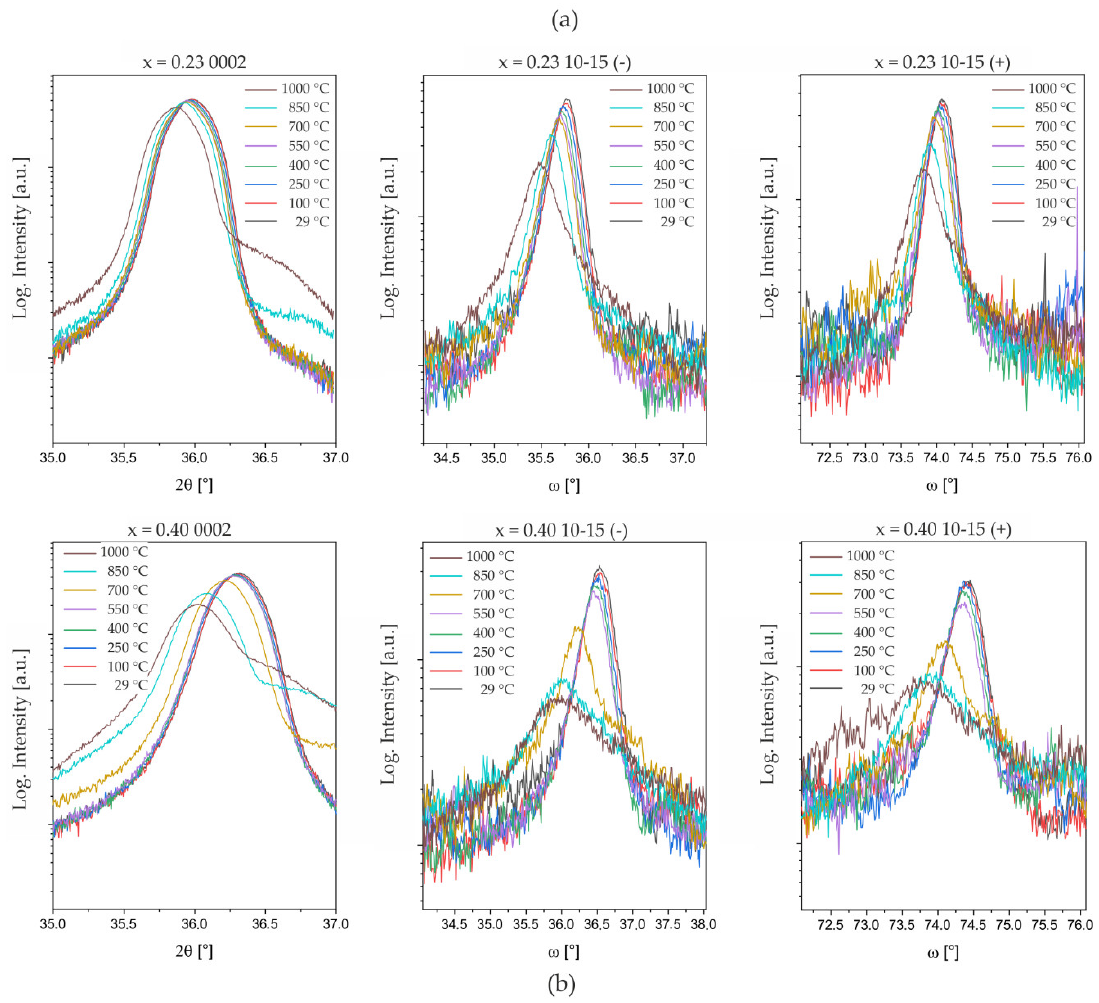
Figure 5. Temperature-dependent changes in symmetric 2θ/θ 0002- and asymmetric ω/2θ 10–15- reflection profiles for ( a ) Al 0.77 Sc 0.23 N and ( b ) Al 0.60 Sc 0.40 N compositions (sample set #2). 10–15-reflections are measured with shallow (−) and steep (+) angles of incidence ω, see [30] for more information on the method.